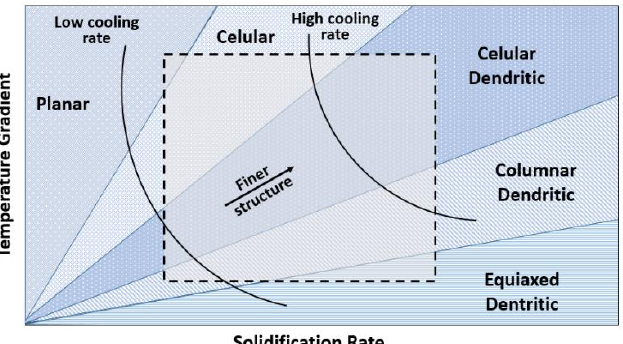
Figure 4. Schematic illustration of solidification growth. The internal square corresponds to typical weld morphology. Adapted with permission from [43]. Copyright 2015 John Wiley & Sons, Inc.